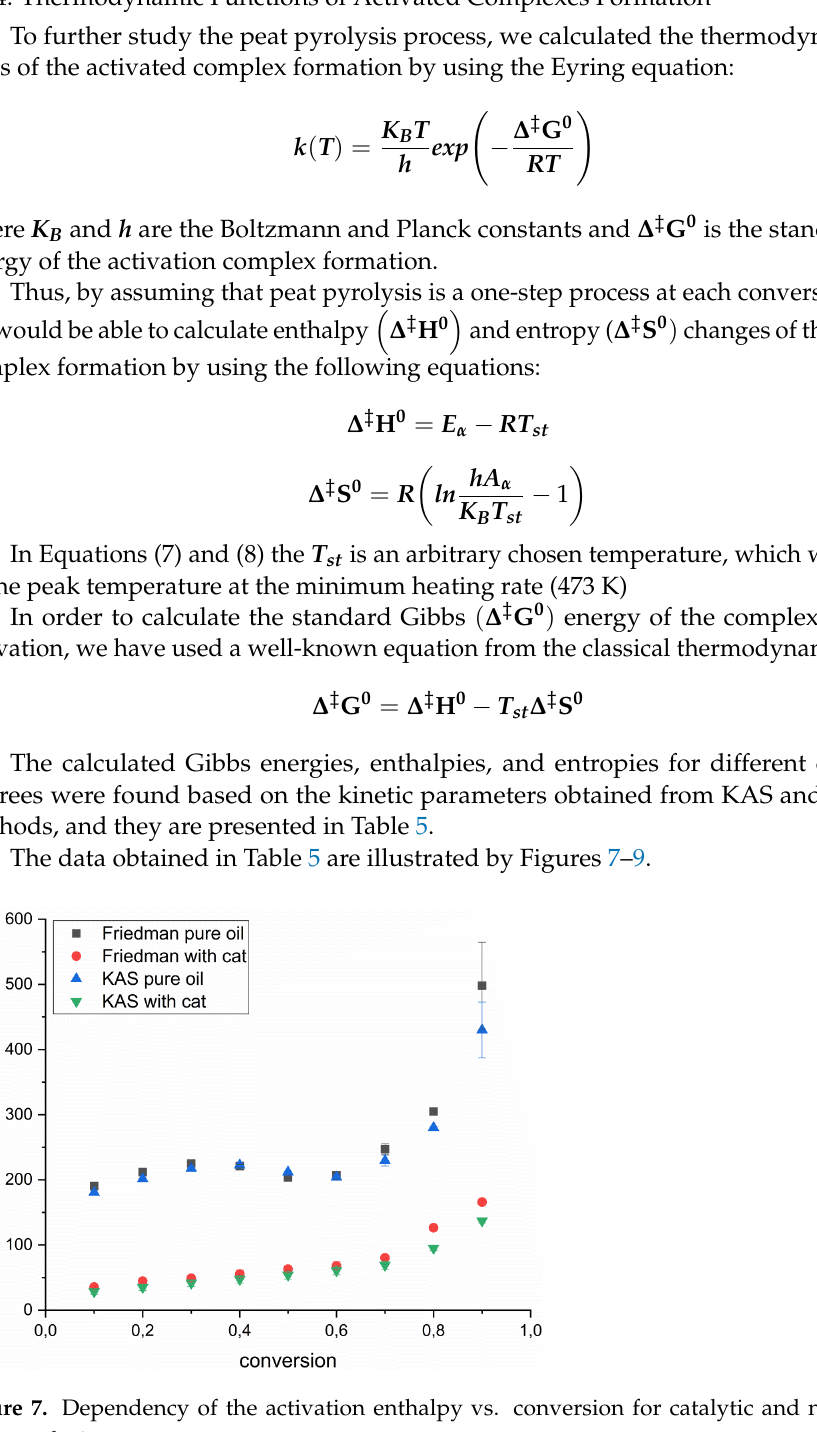
Figure 8. Dependency of the activation entropy vs. conversion for catalytic and non-catalytic peat pyrolysis. Figure 9. Dependency of the activation Gibbs energy vs. conversion for catalytic and non-catalytic peat pyrolysis.